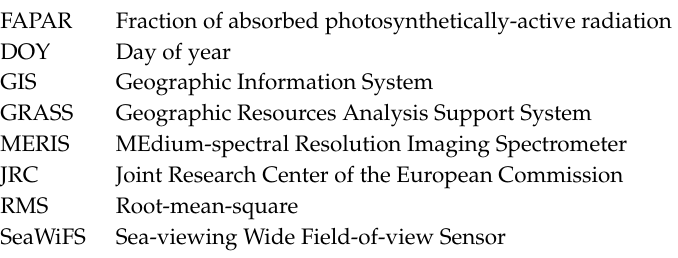
Table S1: Numerical results in a single